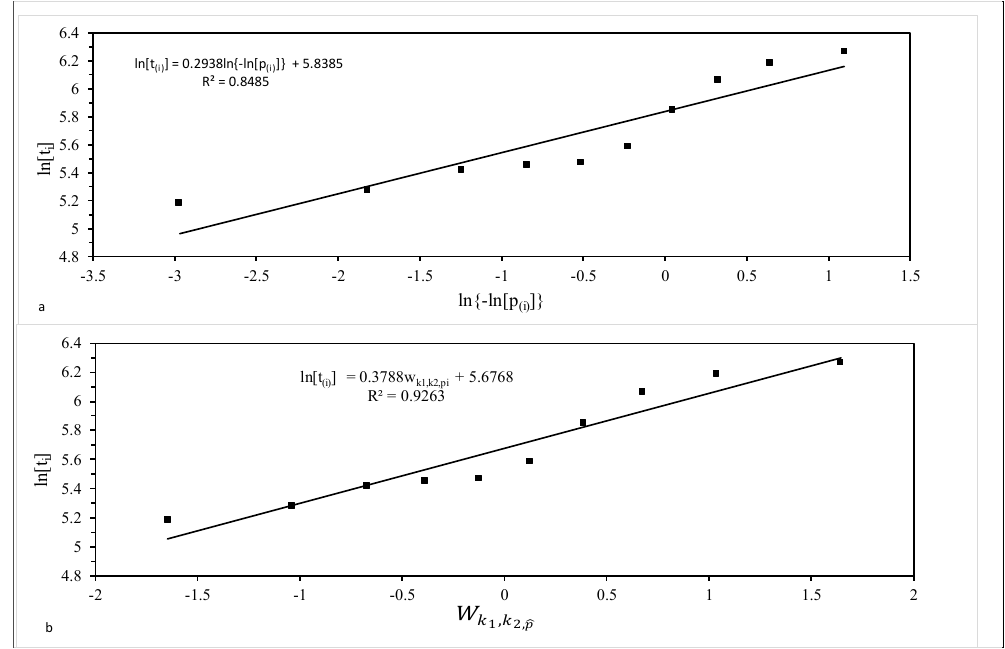
Figure 4. Probability plots for 10 batches of 1Cr-1Mo-0.25V tested at 823 K and 294 MPa: ( a ) the Weibull distribution; and ( b ) the log normal distribution.